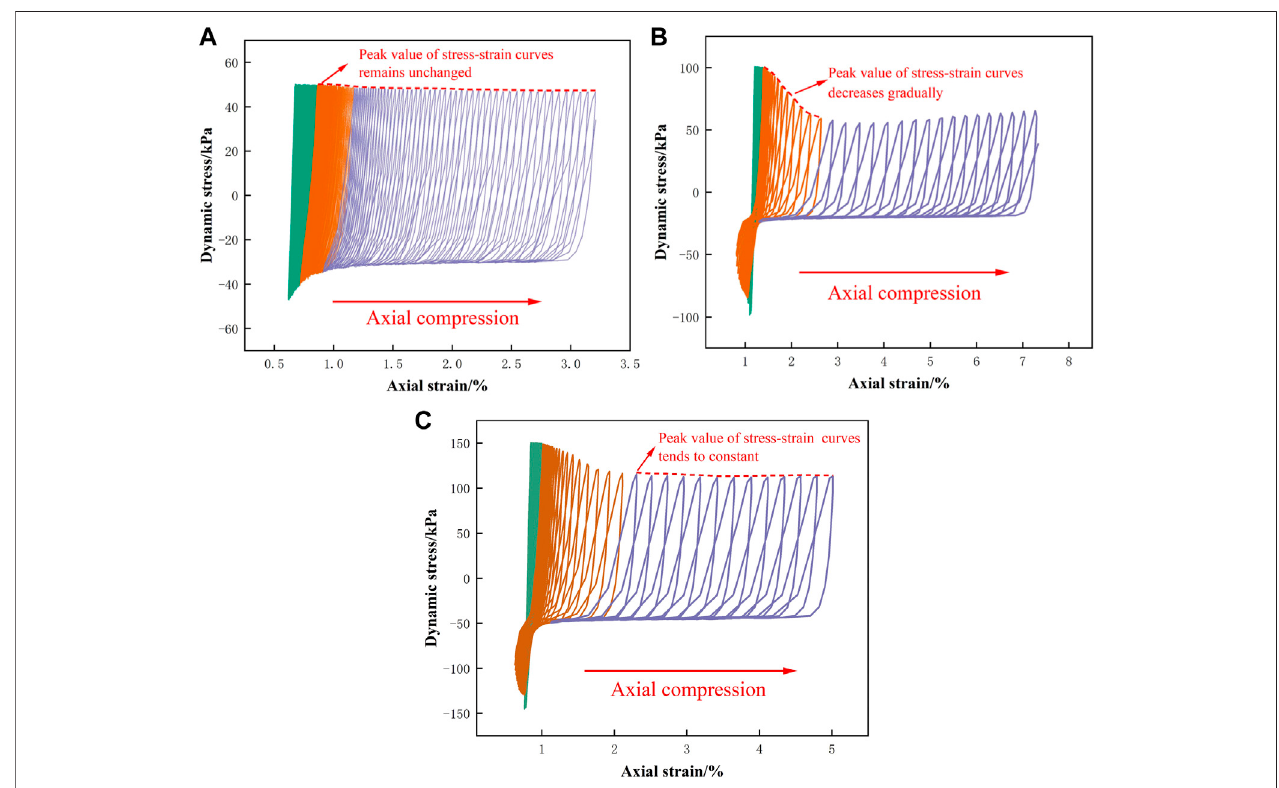
FIGURE7| Dynamicstress – straincurvesunderdifferentstressconditionswiththesameCSR. (A) σ , 0 =100 kPa,CSR=0.25, σ d =50 kPa; (B) σ , 0 =200 kPa,CSR = 0.25, σ